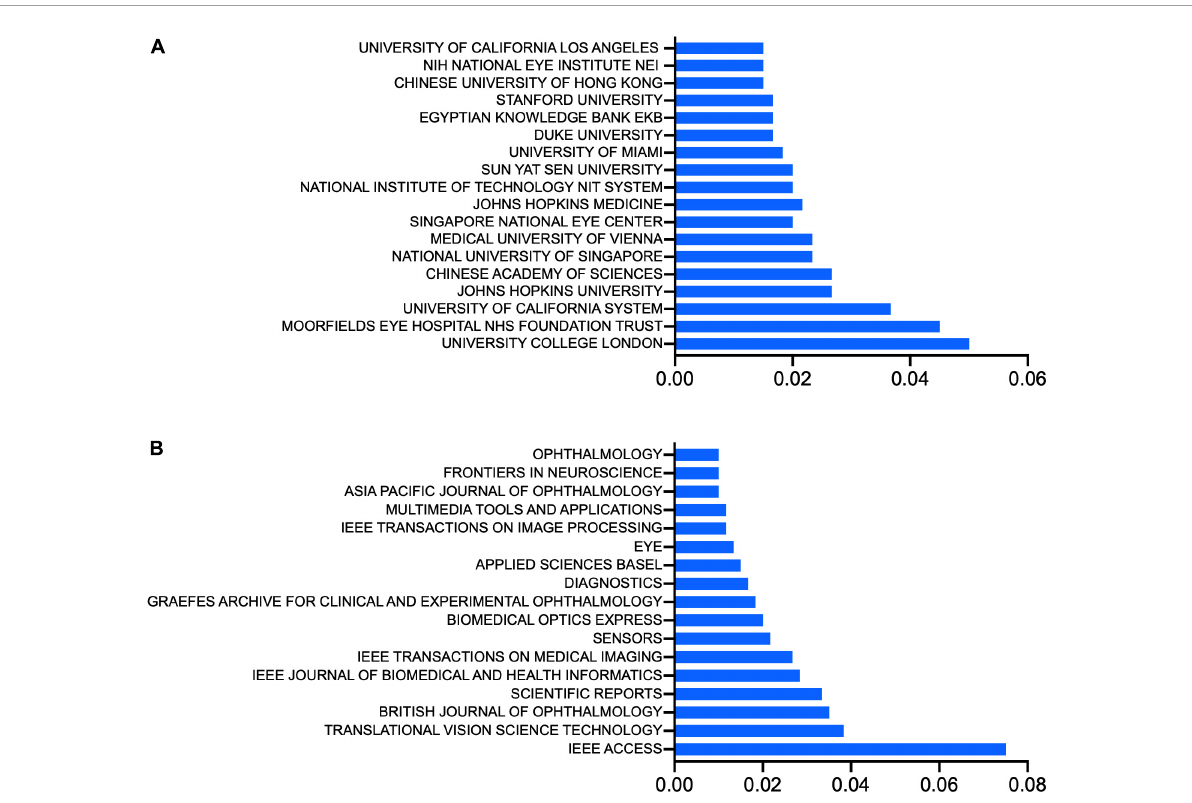
FIGURE3 (A) Top institutions, ranked by the percentage of their publications in the total number of publications of artificial intelligence in retina. (B) Top journals, ranked by the percentage of their publications in the total number of publications of artificial intelligence in retina.